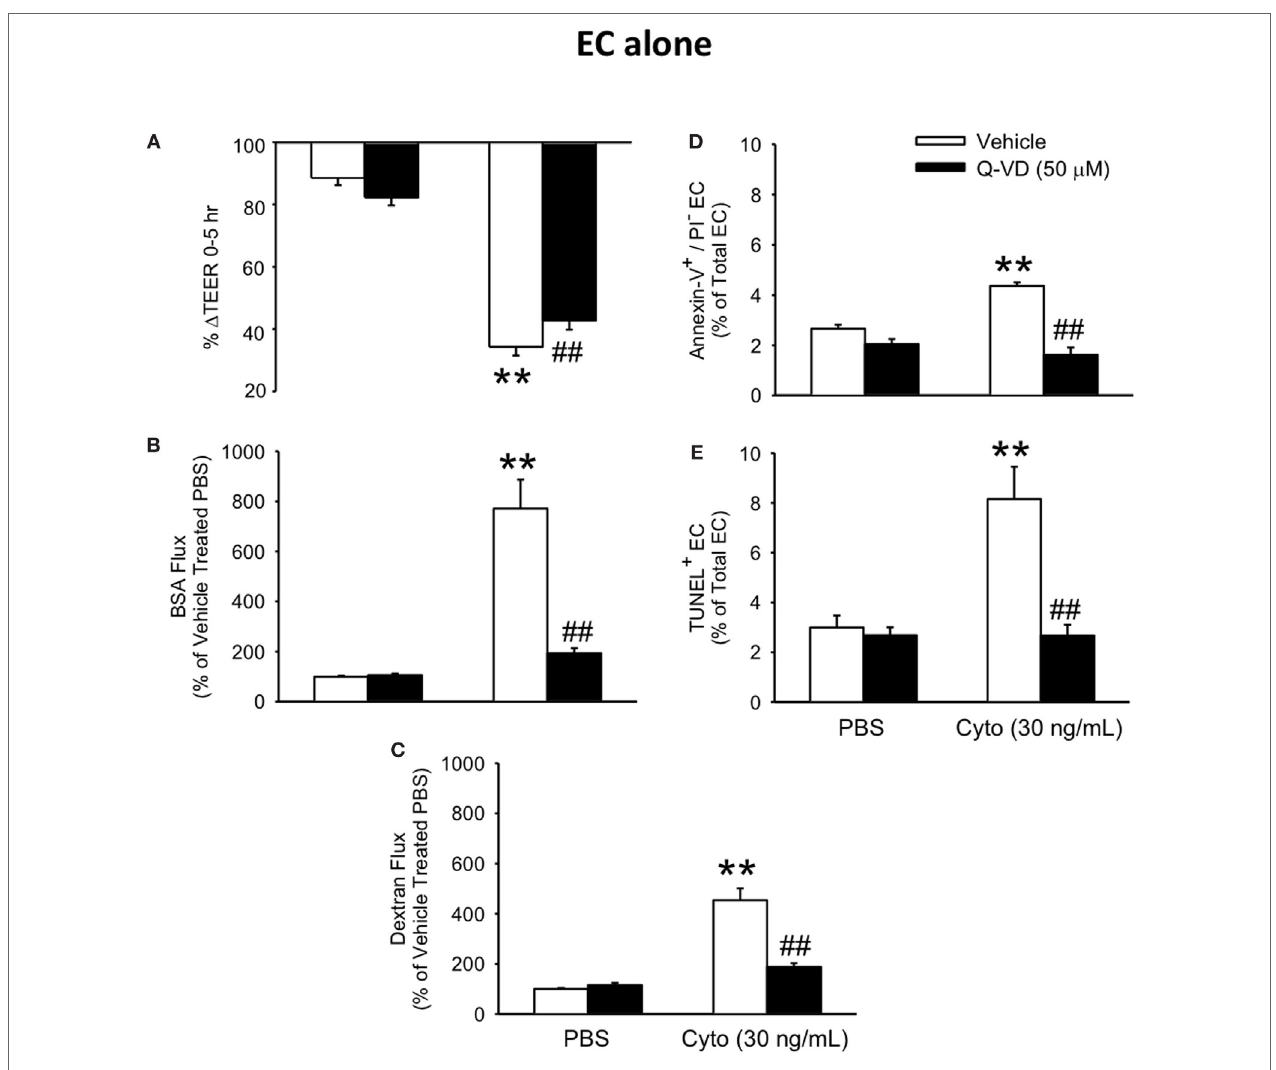
FigUre 3 | Inhibition of caspase activity reduces septic human PMVEC hyper-permeability and the associated apoptosis. Inhibition of caspase activity (Q-VD, 50 μ M) following cytomix stimulation of human PMVEC cultured alone modestly attenuated the septic decrease in transendothelial electrical resistance (TEER) (a) but more markedly blunted the septic increases in macromolecular flux, including Evans blue-albumin (B) and fluoroisothiocyanate-dextran (c) vs. vehicle treatment (dimethyl sulfoxide). Furthermore, treatment of human PMVEC cultured alone with Q-VD also completely prevented the septic increase in the number of Annexin-V + /propidium iodide (PI) − (D) and TUNEL + (e) cells. ** or ## p < 0.01 compared with cytomix or vehicle group, respectively (two-way ANOVA). n =